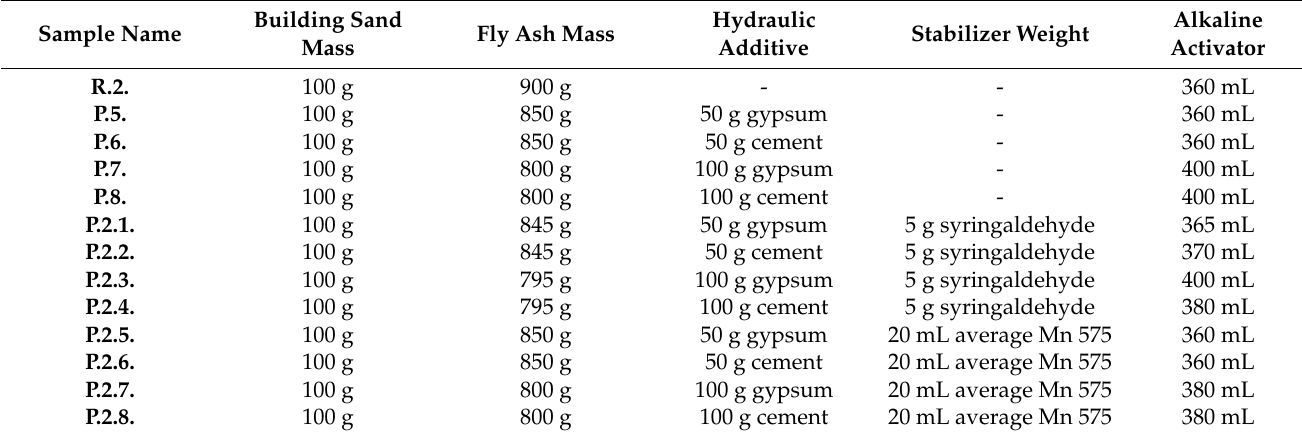
Table 4. Characterization of samples with aluminum powder (1.5 g) as foaming